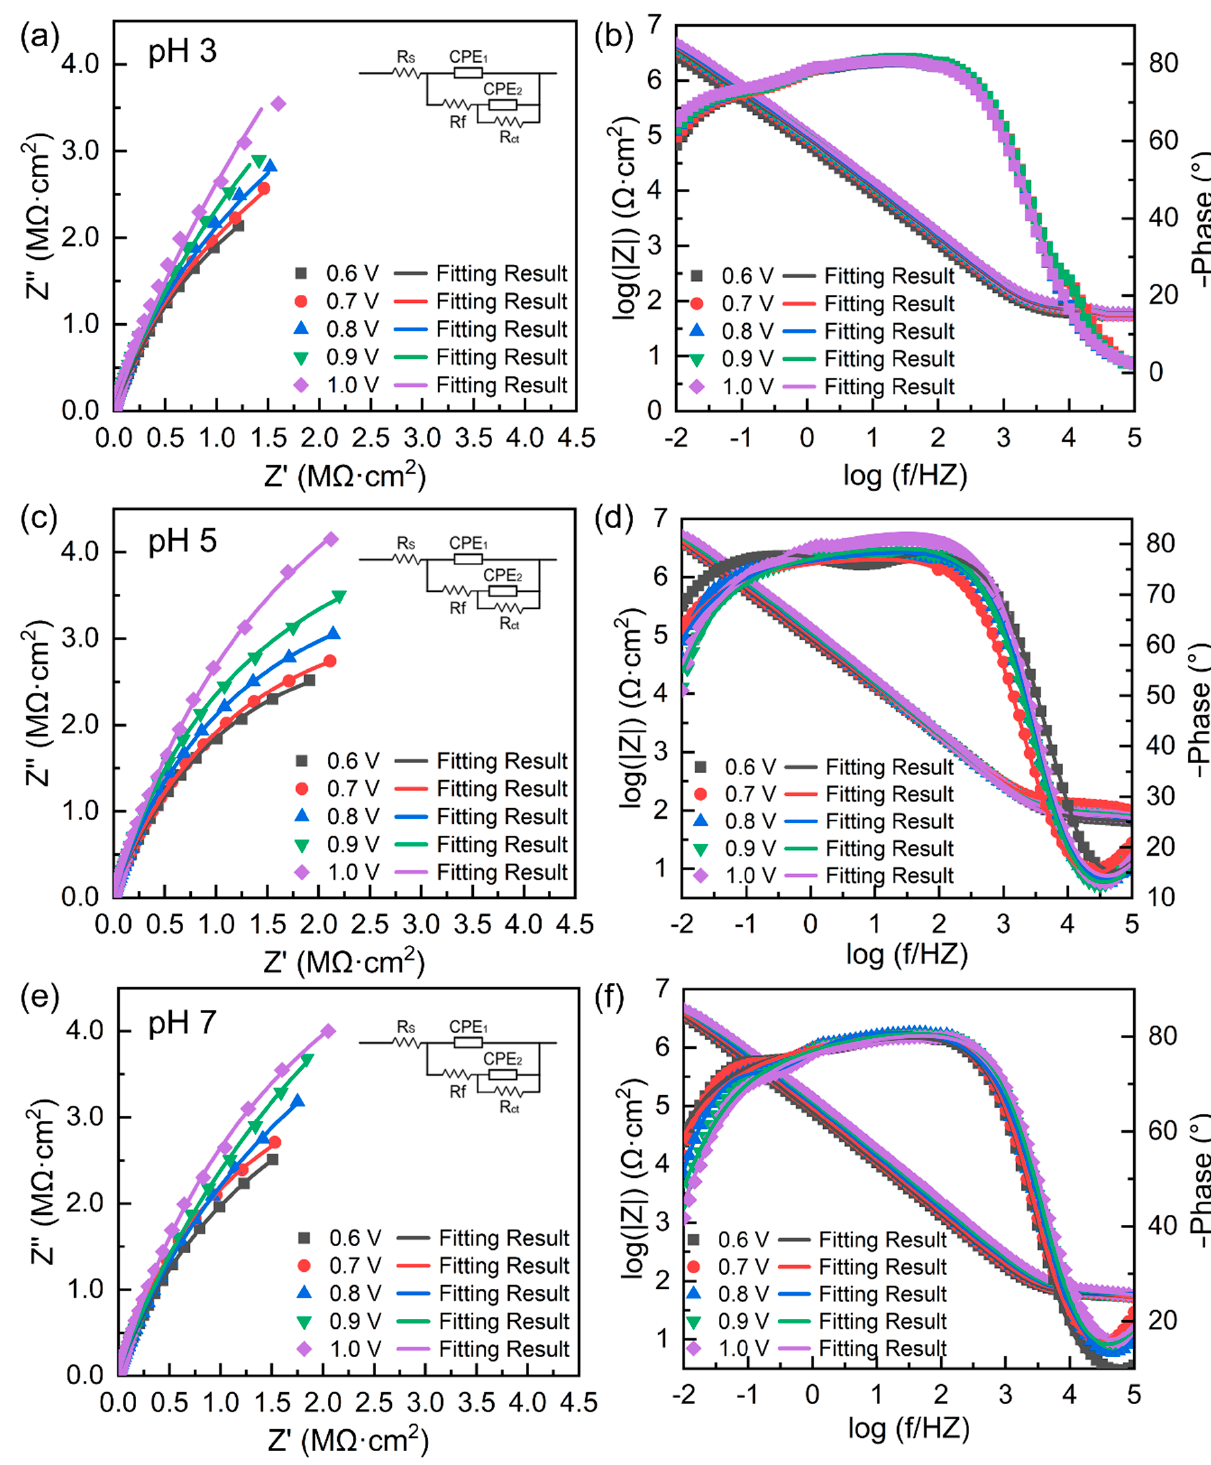
Figure 5. Electrochemical impedance spectroscopy after PP for the LPBFed Ti–6Al–4V, under the potentials of 0.6, 0.7, 0.8, 0.9, 1.0 V SCE in Hank’s solution (pH = 3, 5, 7) at 37 °C. ( a , c , e ) are Nyquist plots; ( b , d , f ) are Bode plots.